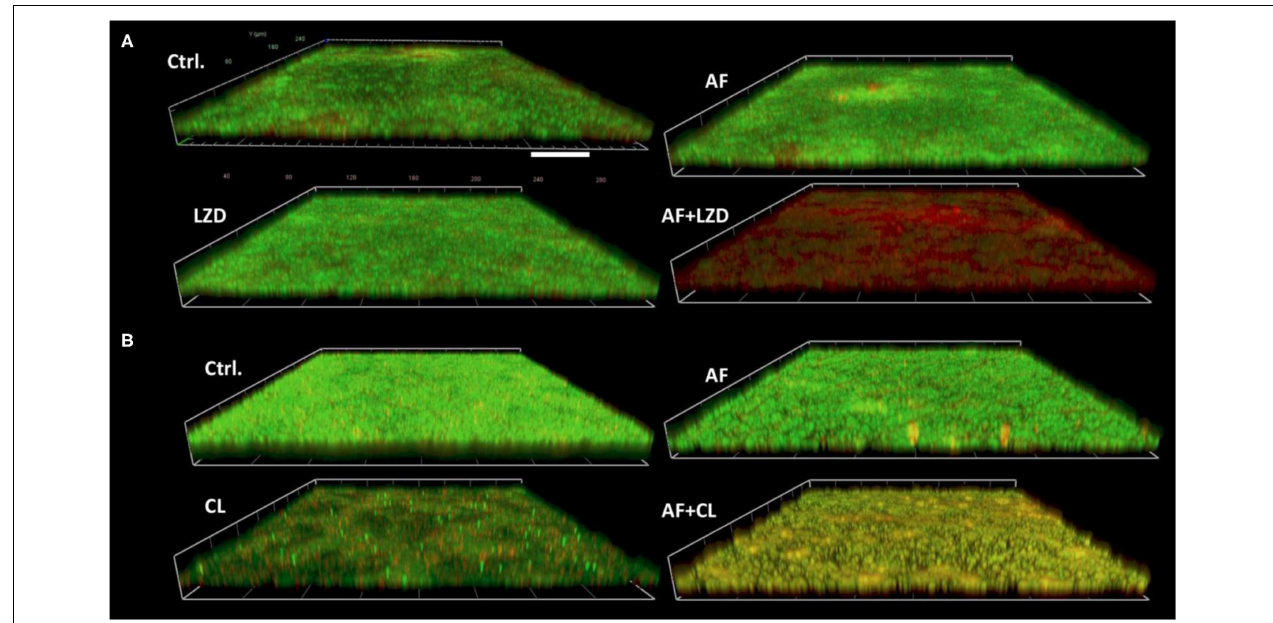
FIGURE 2 | Demonstrative CLSM images of biofilm eradication by AF mono-/combination treatment. Biofilms were performed on glass cover slides and then treated with AF and antibiotics alone and/or in combination for 24 h. The cover slides were stained with the fluorescent dye mixture of SYTO9 (live cells, green) and PI (dead cells, red). (A) S. aureus LZB1, AF 8 mg/L, LZD 16 mg/L. (B) E. faecalis ATCC29212, AF 2 mg/L, CHL 8 mg/L. Scale bar: 40 µ m.